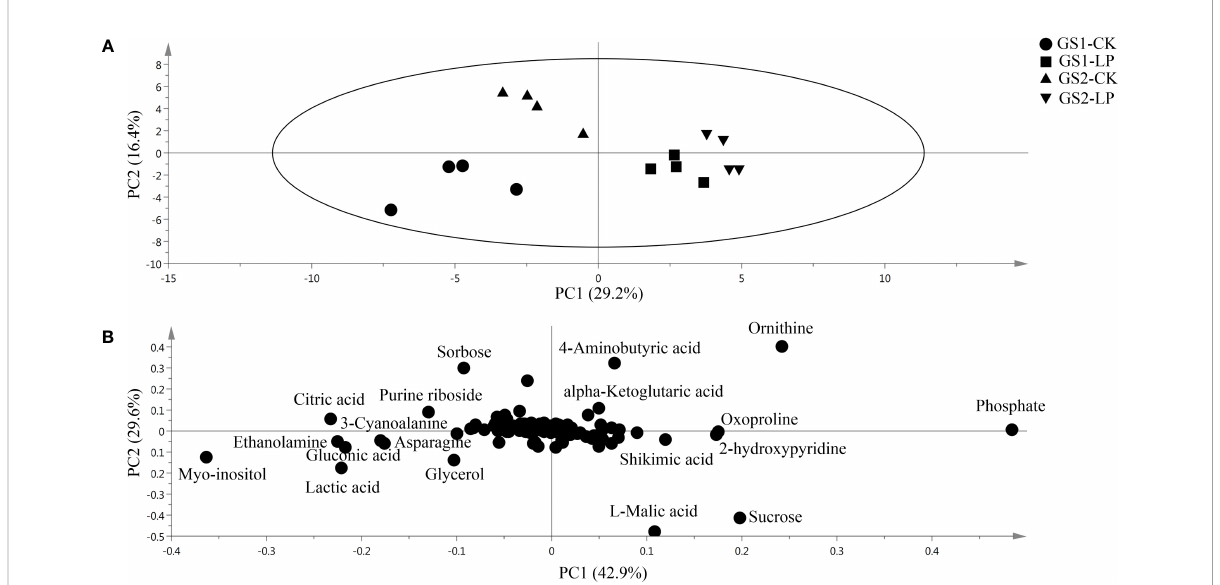
FIGURE 4 (A) Principal component analysis and (B) loading plots of metabolites in roots of two ecotypes of wild soybean seedlings under control and low- phosphorus conditions. PC1 and PC2 are the fi rst and second principal components, respectively. GS1, common wild soybean; GS2, barren- tolerant wild soybean; CK, control group; LP, low-phosphorus stress